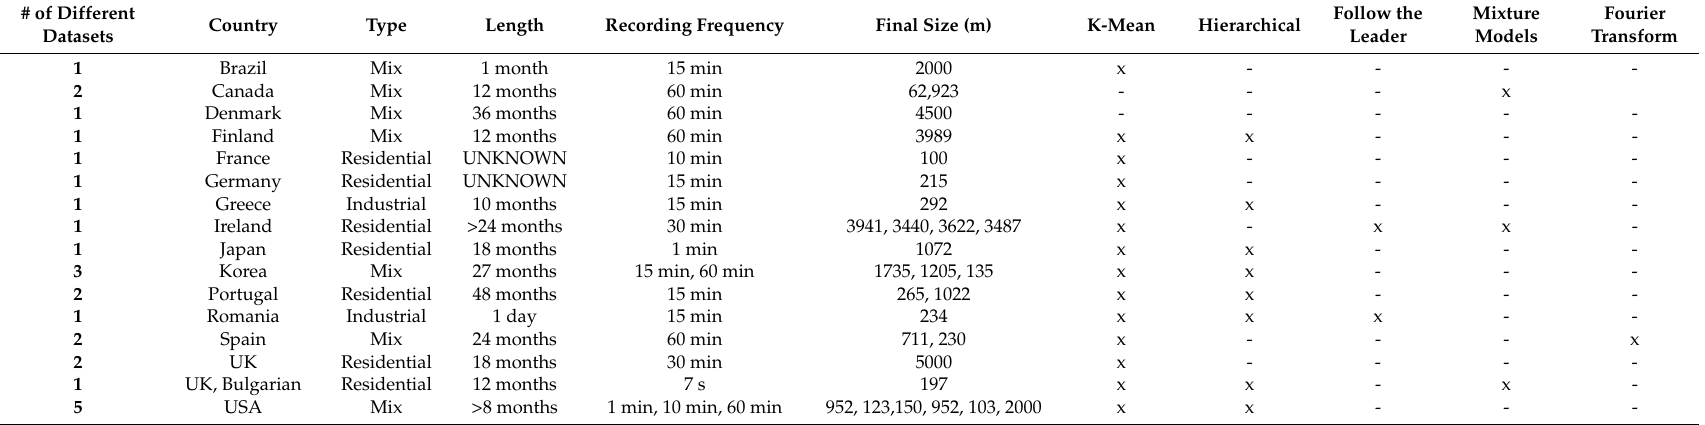
Table 2. Data and method overview table showing the quantity of different datasets encountered in each country and the main attributes from the data description score, Country, Type, length, frequency, final sample size, and the most prevalent classification encountered in this review. Denmark has no method listed as the classification used is a combination of regression and survey data.